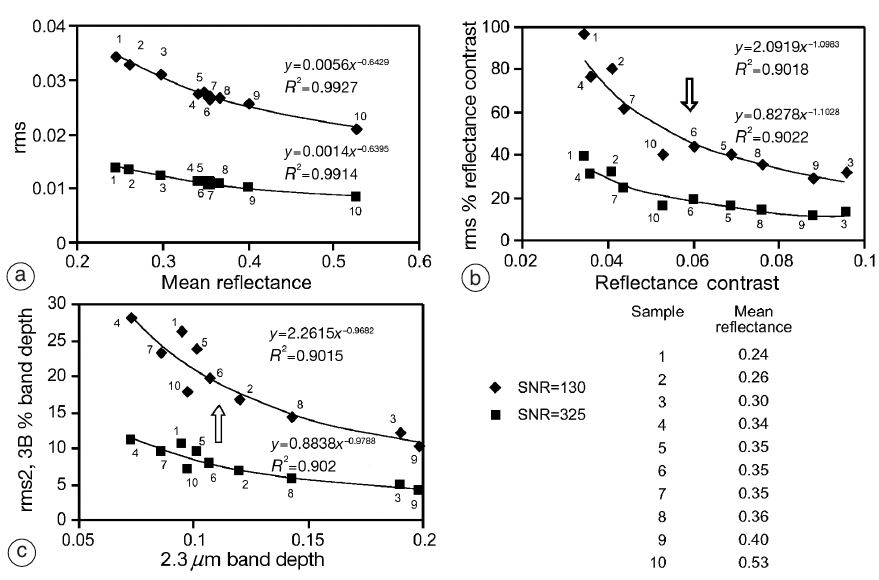
Fig. 7a-c. Noise content in the data as a function of sample mean reflectance (a), reflectance contrast (b), and CO 3 –2 band depth (c), for two sensor SNRs. Noise in the data is expressed as the root mean square of the ratio between noisy and original spectra (rms); in (b) and (c) is expressed as percentage of reflectance contrast and 2.3 n m band depth, respectively. Goodness of fit for SNR 130: 0.656; for SNR 350: 0.852. Correct classifica- tion for SNR 130: 40%; for SNR 350: 60%. Arrows: spectral contrast and band depth threshold